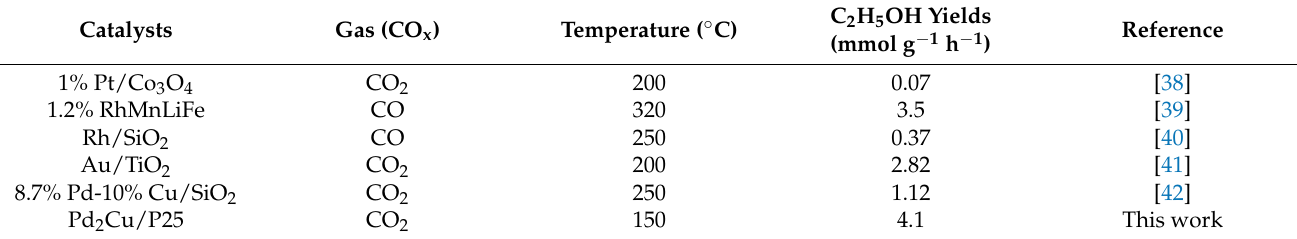
Figure 4. ( a ) Schematic diagram of photothermal CO 2 reduction using photoreactor, ( b ) GCMS spec- trum of ethanol after 1h UV-Vis light irradiation at 80 ◦ C. ( c ) The overall process of CO 2 reduction and H 2 O oxidation on Pd 2 Cu/P25 (CB: conduction band, VB: valence band, h + : holes, and e − : electrons).